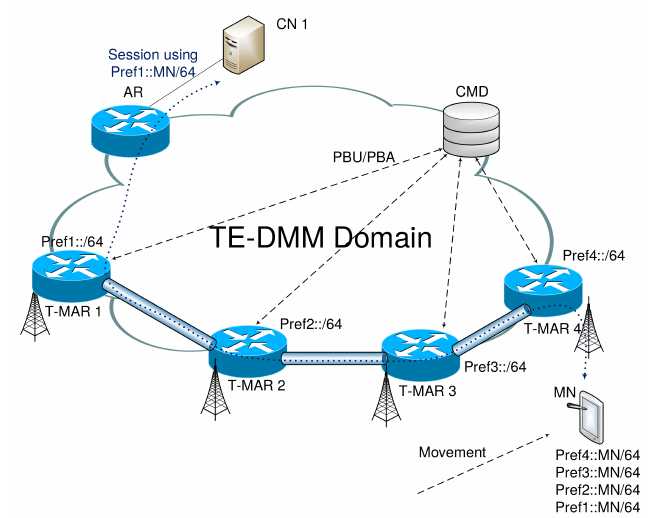
Figure 2. Basic operation of Proposed Network Architecture: Tunneling Extension to Distributed Mobility Management